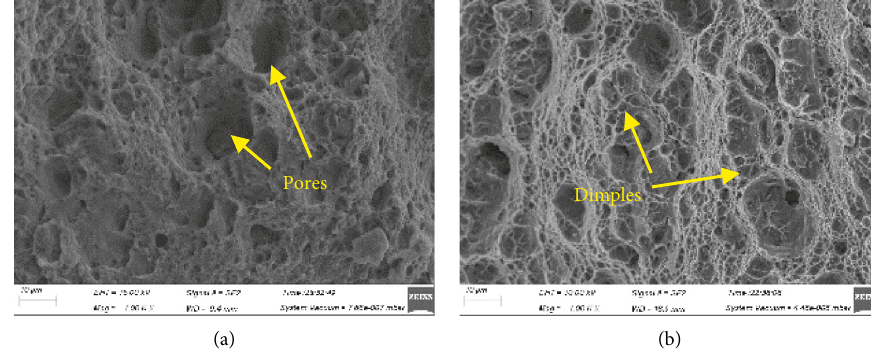
Figure 5: Fracture morphology at different stirring temperatures: (a) 750 ° C; (b) 650 ° C.